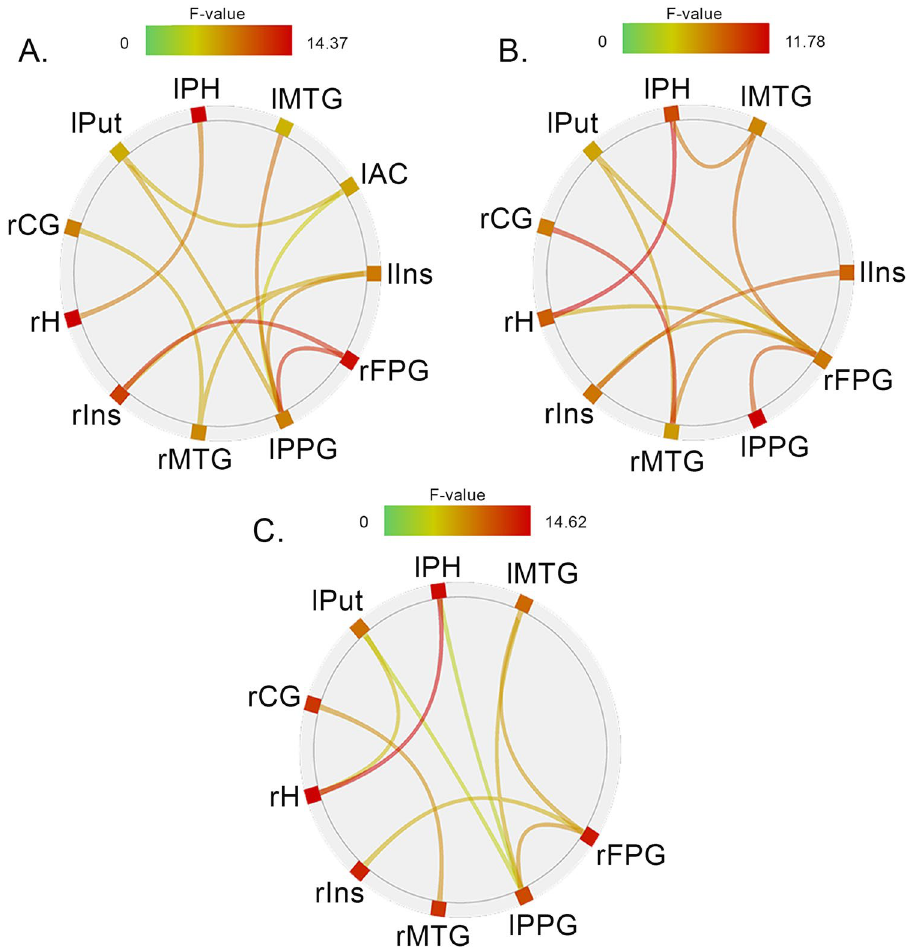
Figure 5. Functional connectivity analysis. FDR corrected ( < 0.05 at the seed level) correlations for ( A ) A complete repetition, ( B ) A complete alternation and ( C ) A partial repetition of the emotion and motor response in the binding task between our 11 ROIs of interest: The left parahippocampal gyrus (lPH), the left middle temporal gyrus (lMTG), the left anterior cingulate gyrus (lAC), the left insula (lIns), the right frontal precentral gyrus (lFPG), the left parietal postcentral gyrus (lPPG), the right middle temporal gyrus (rMTG), the right insula (rIns), the right hippocampus (rH), the right cingulate gyrus (rCG) and the left putamen